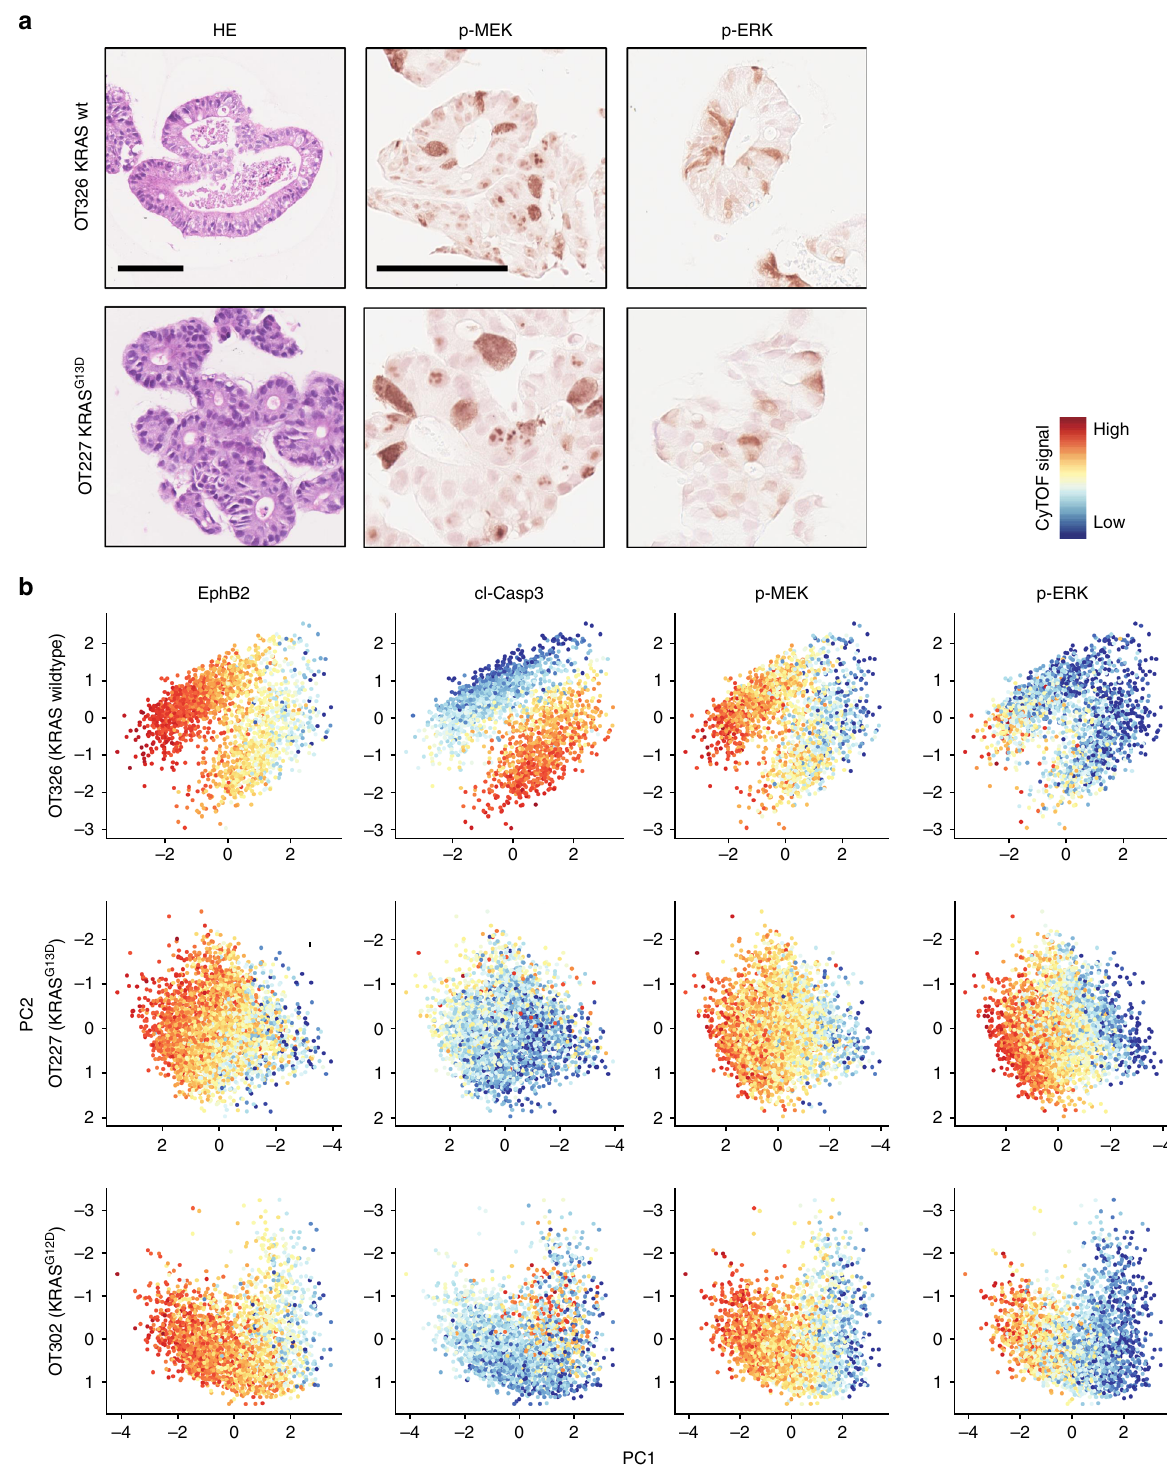
Fig. 1 Graded MEK and ERK phosphorylation in patient-derived organoids. a Haematoxilin-eosin (HE) staining and phospho-MEK and phospho-ERK immunohistochemistry of two PD3D lines OT326 and OT227 that are KRAS-wild-type and KRAS-mutant, respectively. Scale bars denote 100 µ m for HE and immunohistochemistry. b CyTOF analysis of PD3Ds. Principal component analyses, colour-coded for EphB2, cleaved Caspase, phospho-MEK and phospho-ERK are shown. Red, yellow and blue colours of the scale represent high, intermediate and low signals, respectively. CyTOF data is available as a Source Data fi